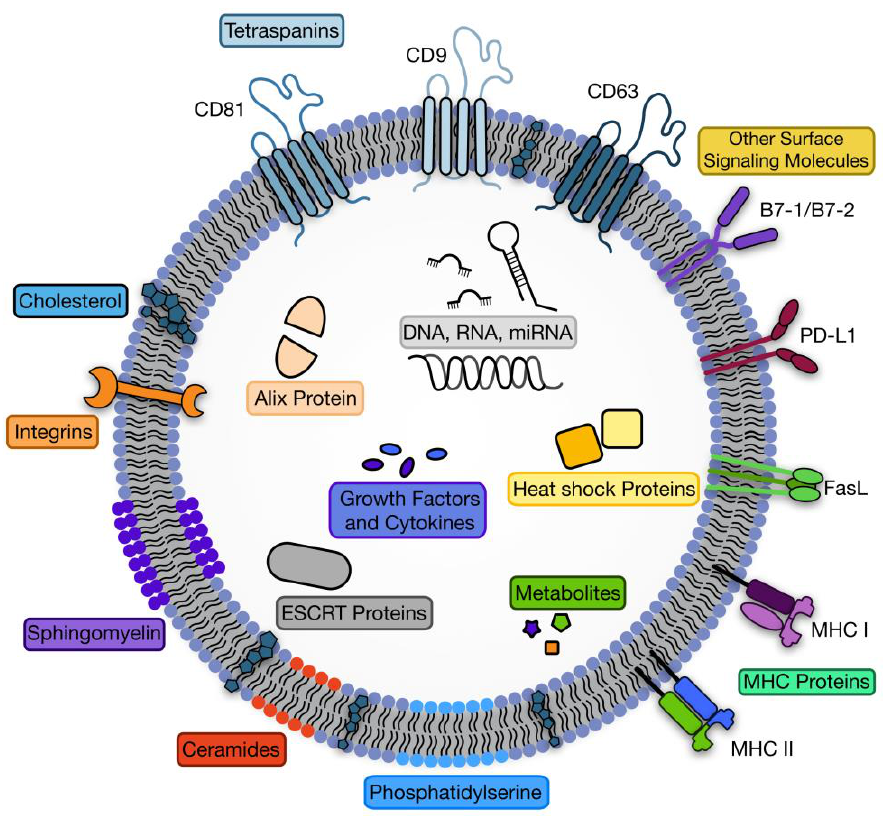
Figure 2. The structure of exosomes including common cargo